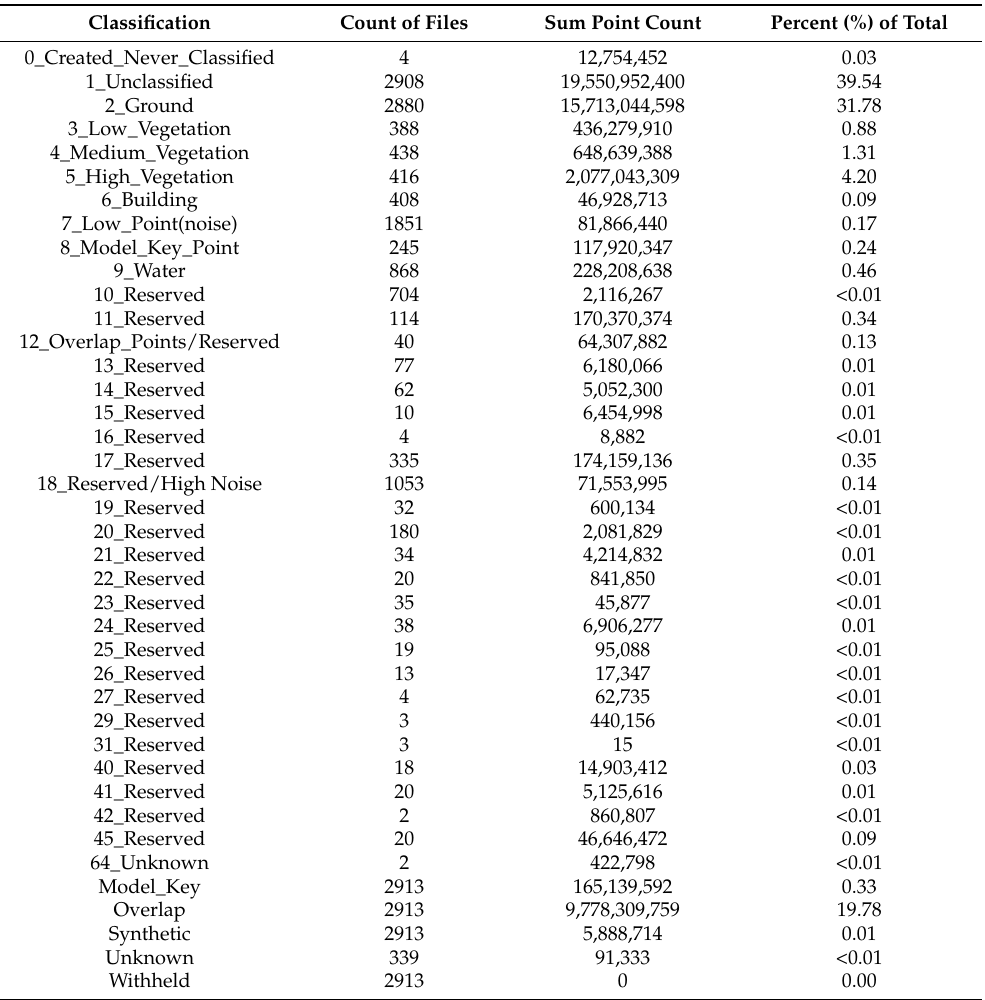
Table 9. Composition of classifications from stratified random sample